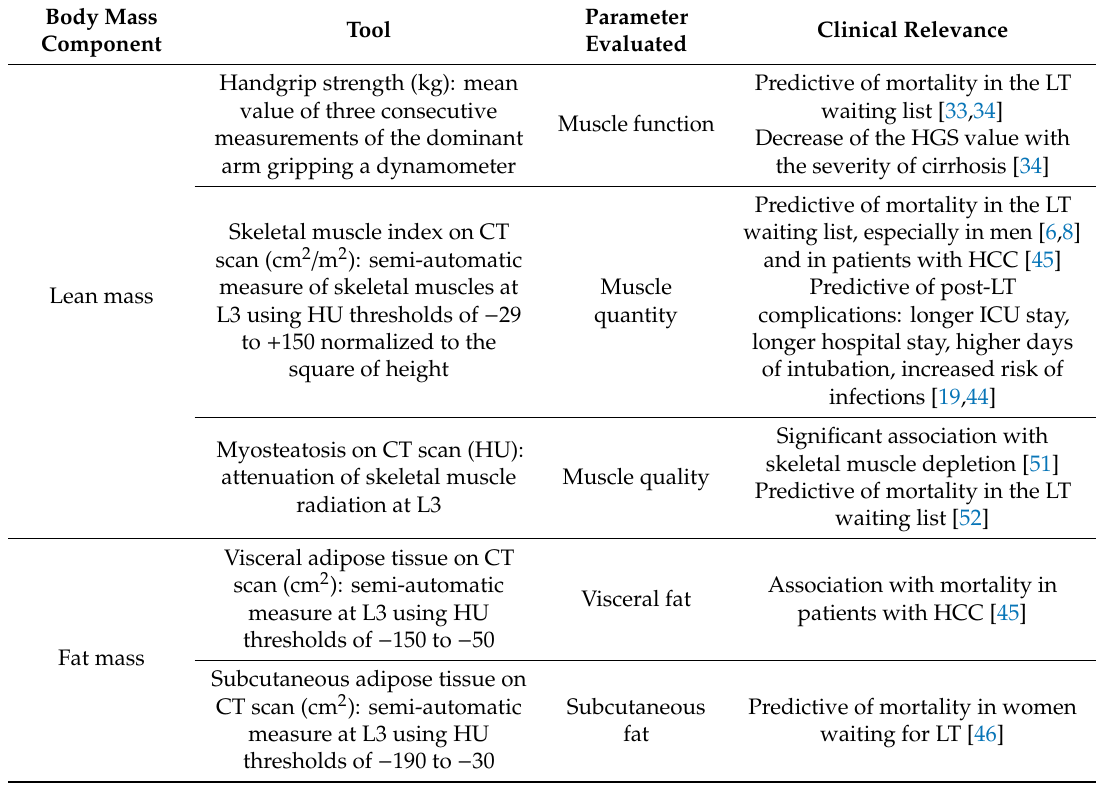
Table 2. Main tools for the assessment of body